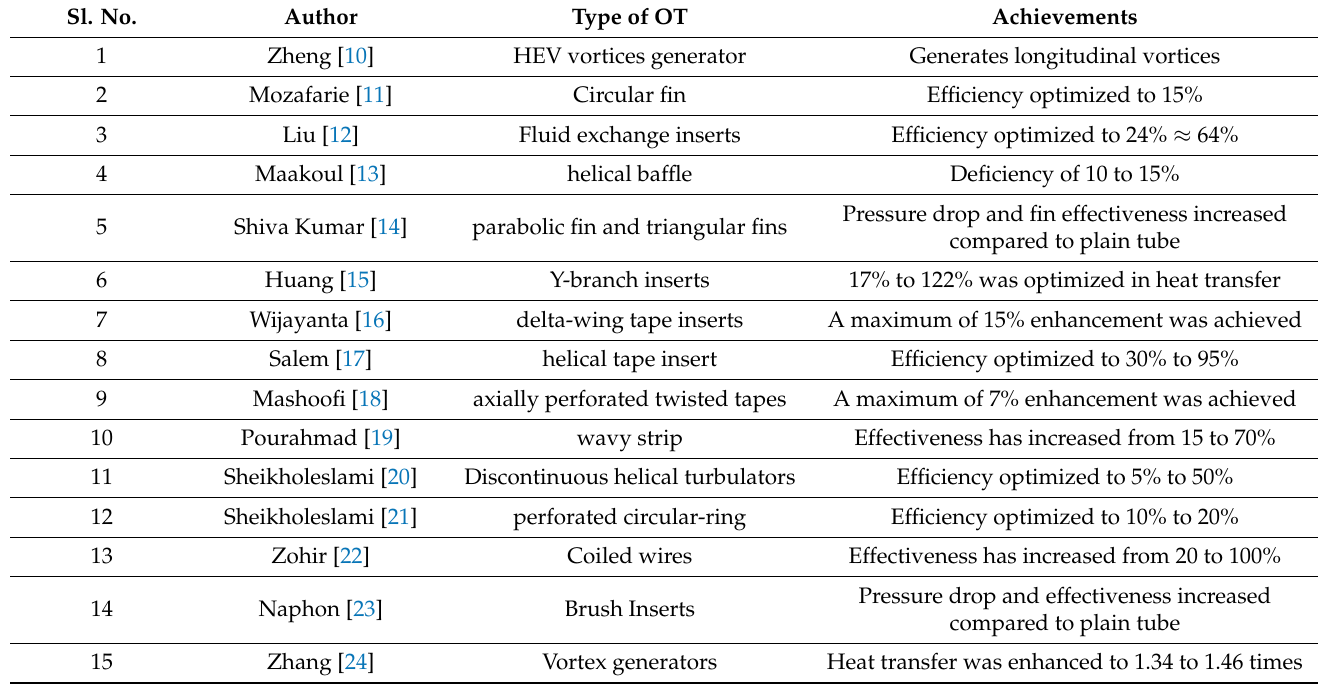
Table 1. Optimization Techniques in